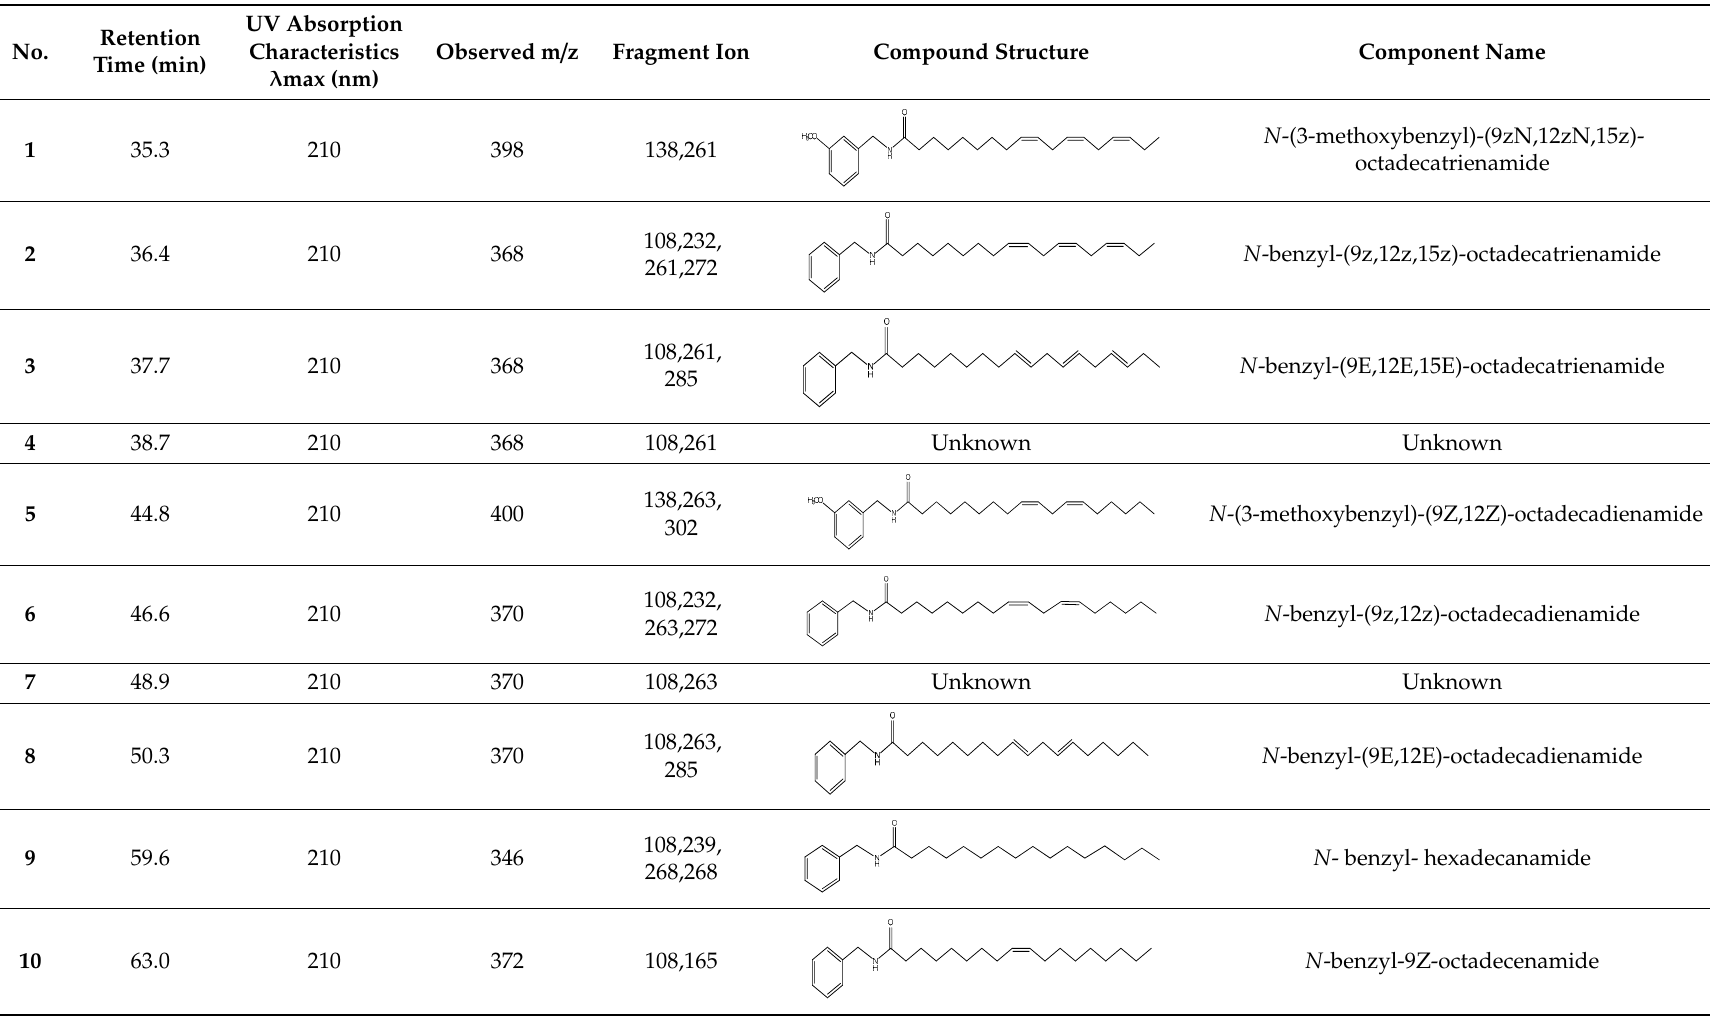
Table 1. HPLC- ESI-MS data of 10 common peeks.